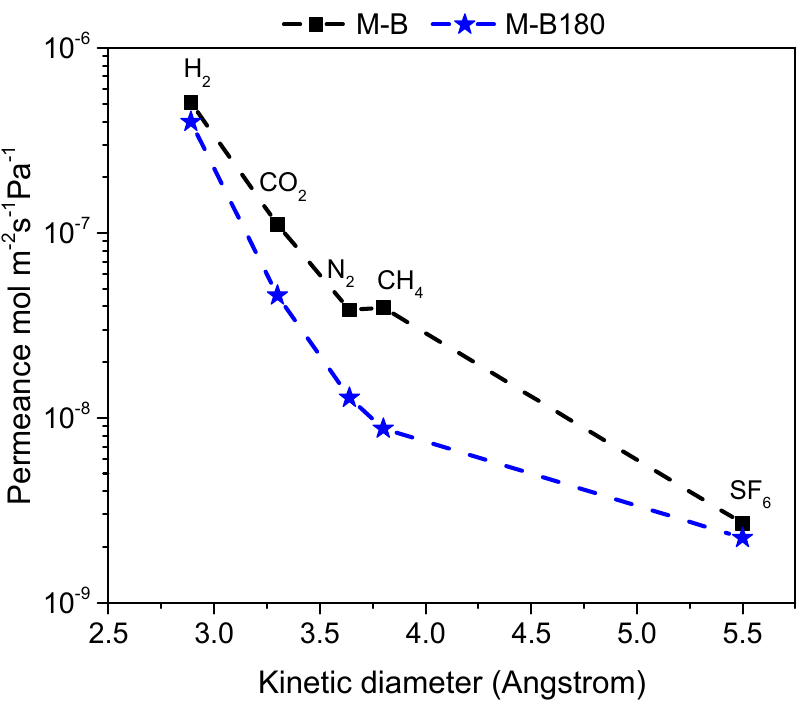
Membranes 2022 , 12 , x FOR PEER REVIEW 11 of 16 Figure 5. Single gas permeance of various gases measured at 250 ◦ C and P f = 3 bar for commercial Figure 5. Single gas permeance of various gases measured at 250 °C and P f = 3 bar for commercial HybSi ® membrane M-B compared to the modified membrane M-B180 included. HybSi ® membrane M-B compared to the modified membrane M-B180 included.